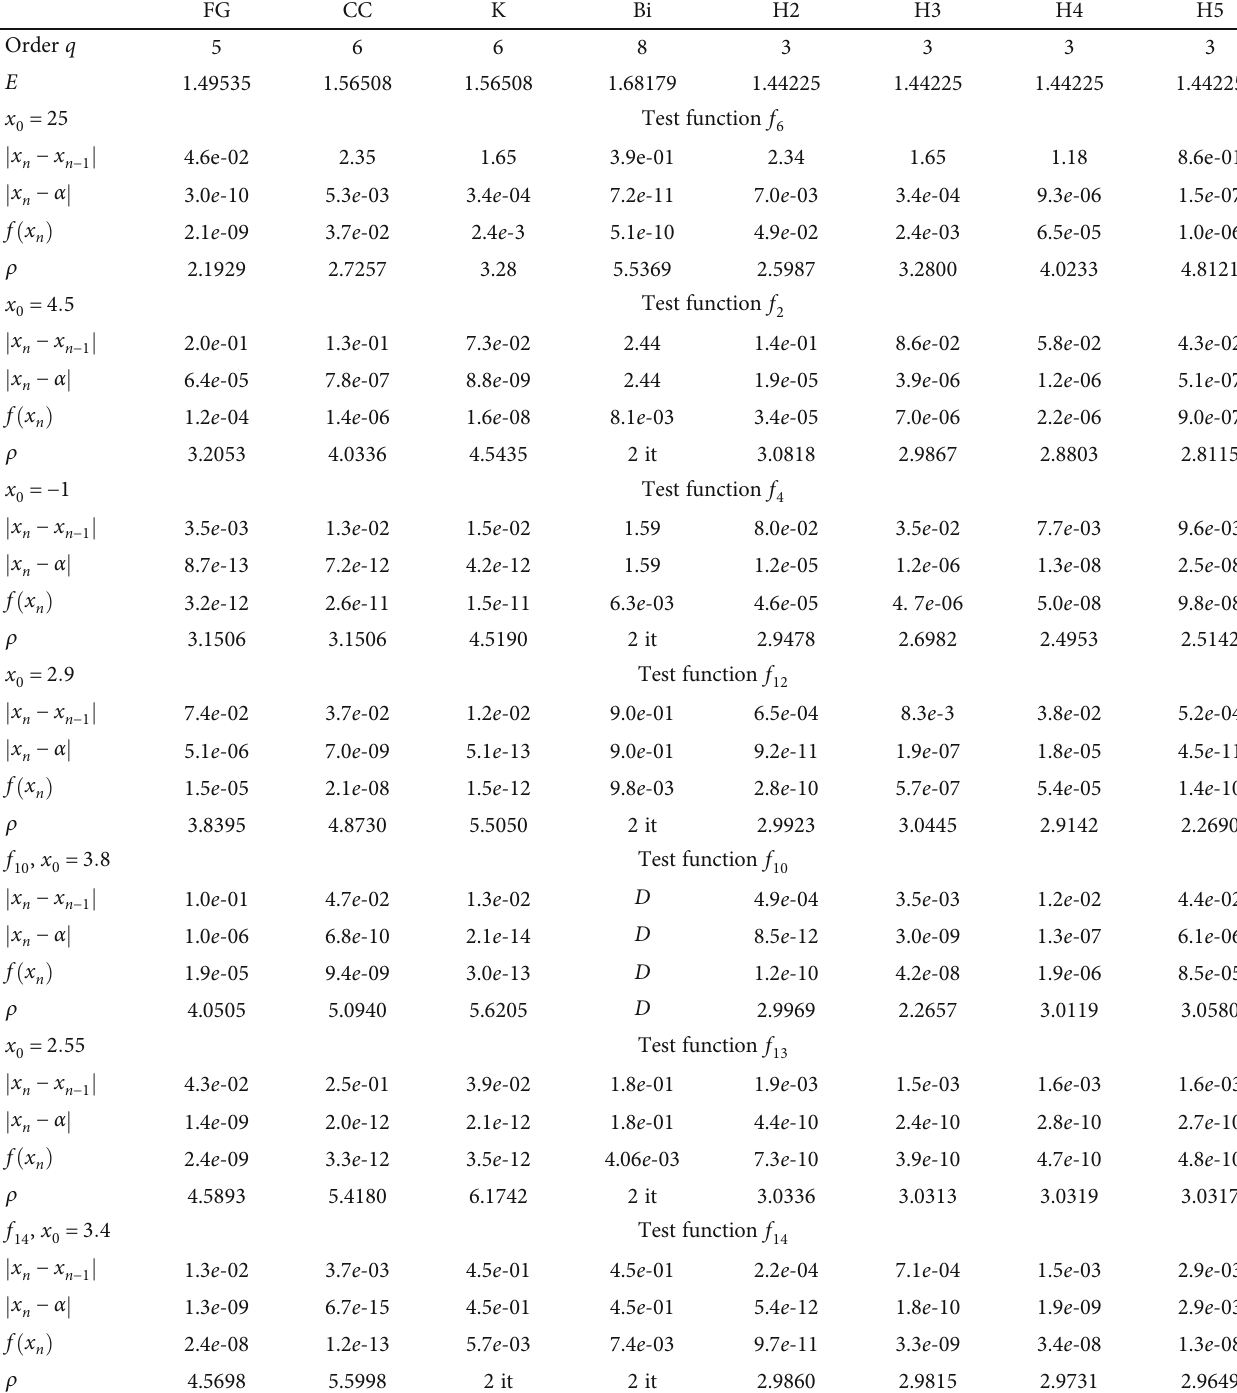
Table 5: Comparison of methods of various orders in terms of the error in the consecutive iterations, the absolute value of the error, the absolute value of the function, and the computational order of